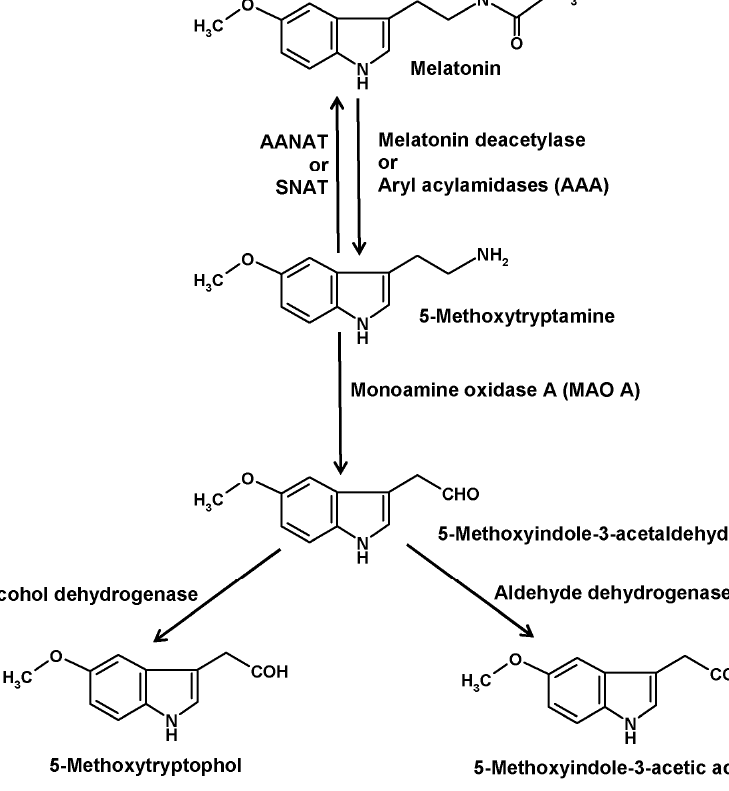
Figure 3. Role of 5-methoxytryptamine in melatonin metabolism.